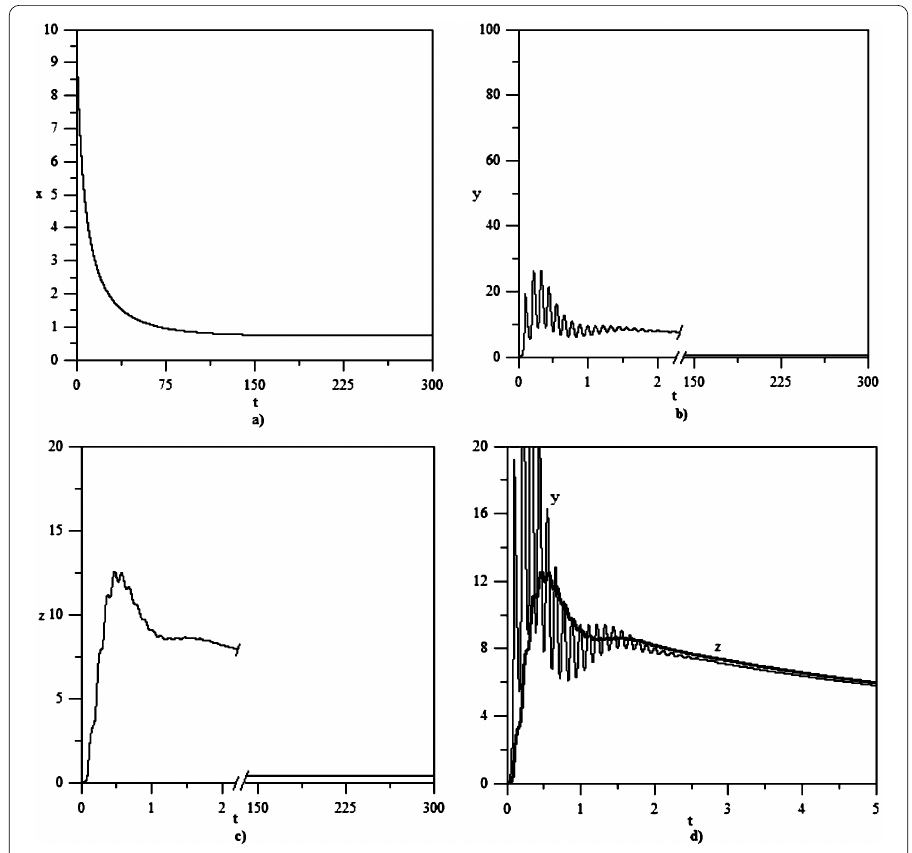
Figure 6 ( a ), ( b ), ( c ), ( d ) shows the numerical simulation of the model with delay whilst the reproductive number is not constant. Figure ( a ) shows how the quantum of CD4+ T cells decreases over time and assume a constant value: Figure ( b ) and ( c ) shows fluctuations of HIV and CTL in the blood. The Virus has reached an uncontrollable state as CTL decreases. Figure ( d ) shows an escalation of the virus component whilst CTL diminishes drastically for the interception of